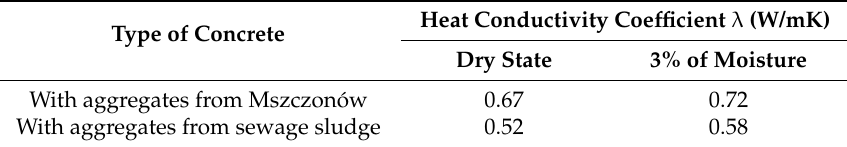
Table 6. Heat conductivity coefficients of lightweight aggregate-concretes.